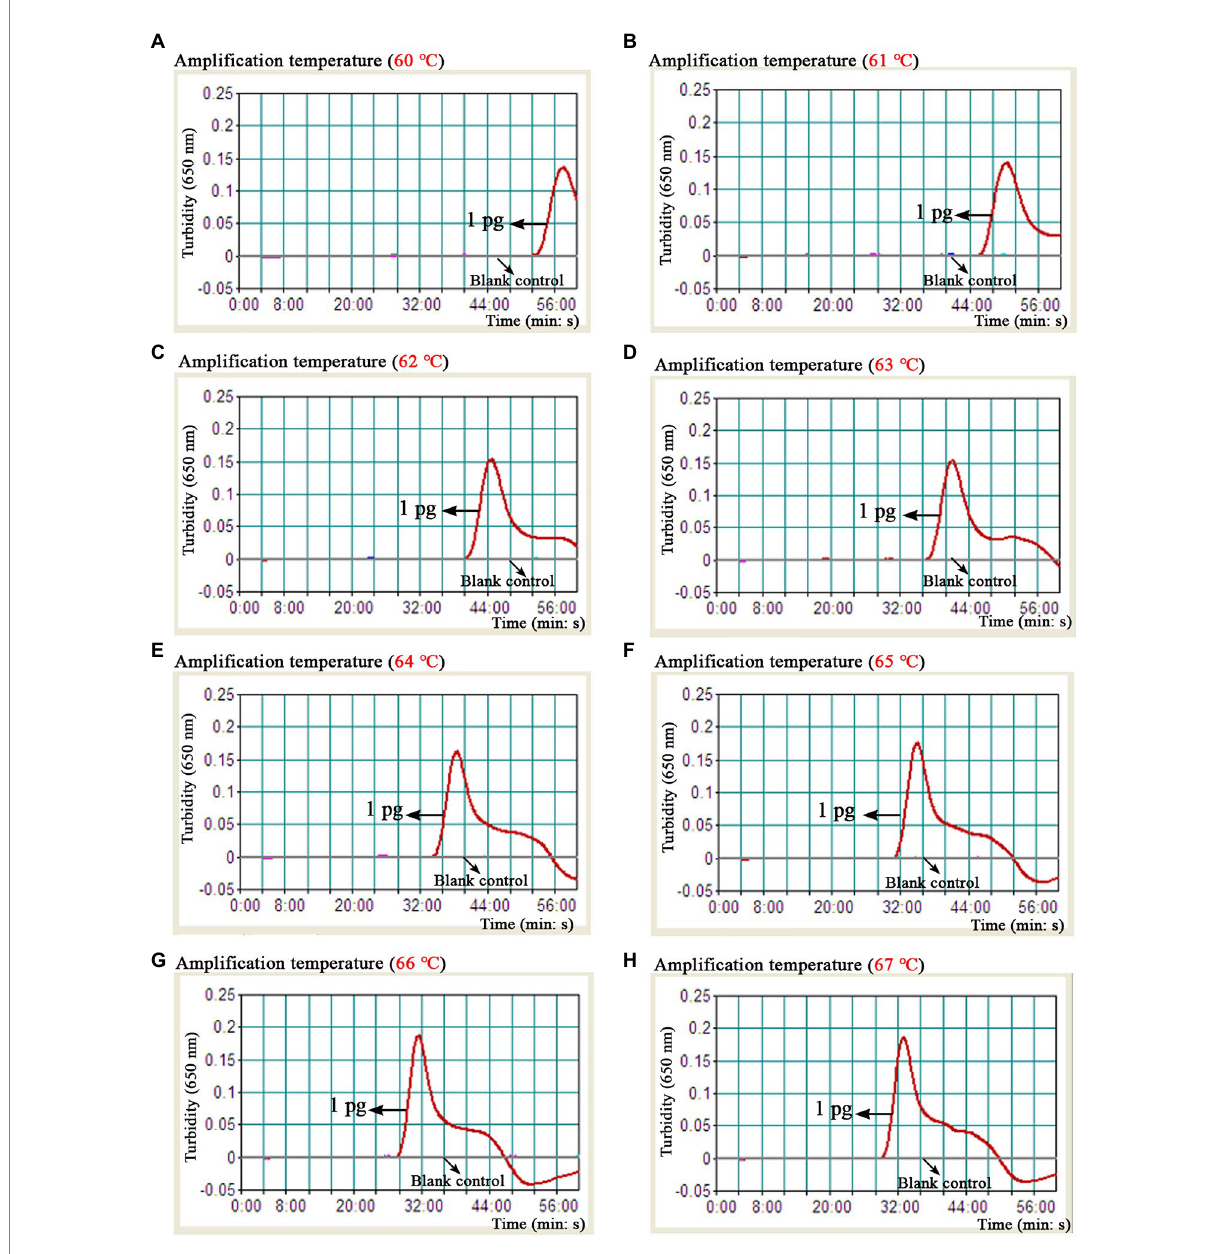
FIGURE 4 Optimal reaction temperature of the B. abortus -MCDA-LFB assay. The results of the B. abortus -MCDA-LFB assay were reported using a real-time turbidimeter, and a turbidity value greater than 0.1 was considered as positive (threshold value was 0.1). Eight dynamic curves (A–H) showed that the amplification efficiency of the B. abortus -MCDA-LFB assay was relatively high when the temperature range was 66 ° C to 67 ° C ( G,H ), and the optimal temperature was 66 ° C ( G ). MCDA, multiple cross displacement amplification; AuNPs-LFB, gold nanoparticles-based lateral flow biosensor; TL, test line; CL, control